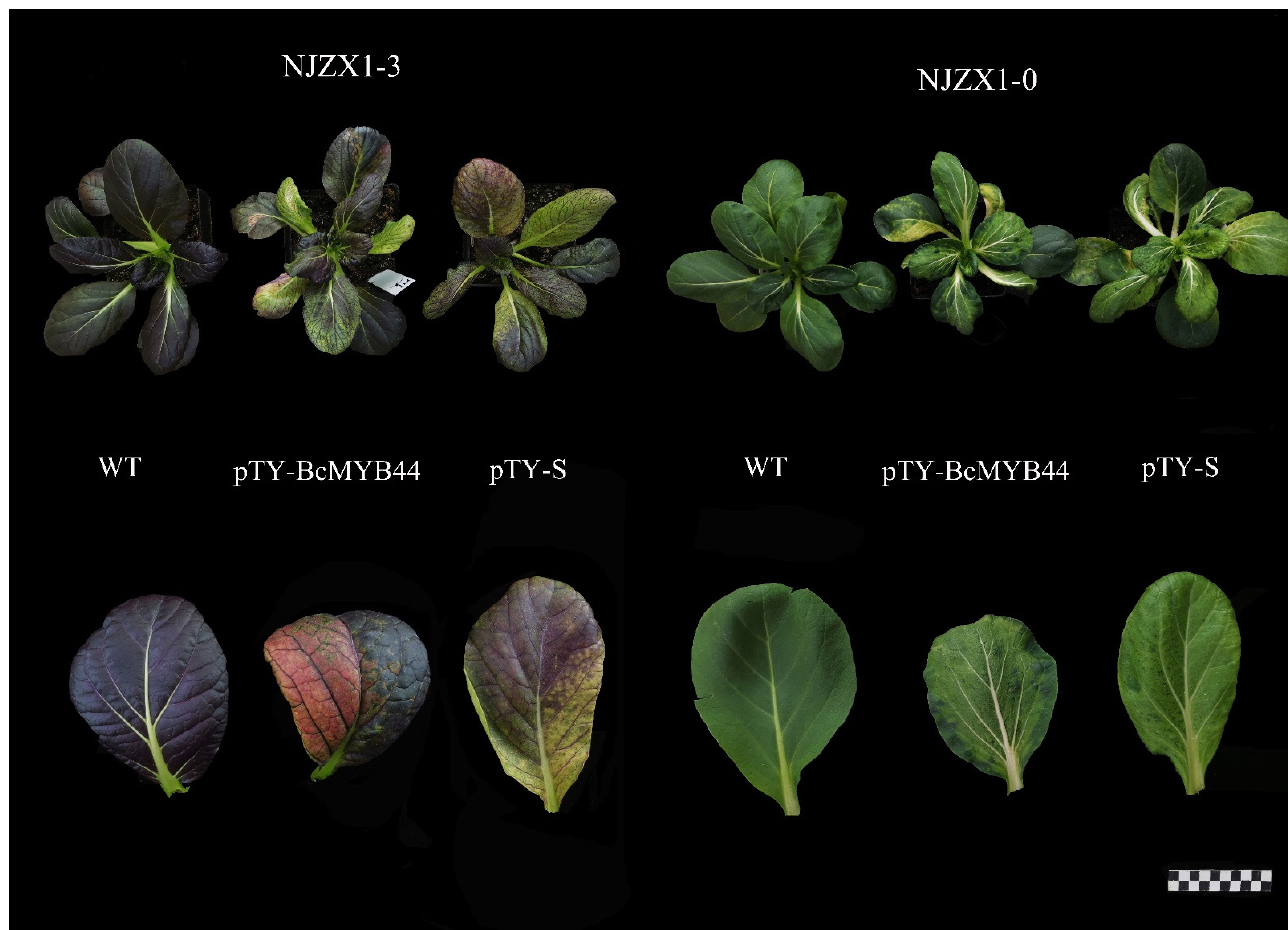
Figure 7. Phenotypic changes of non-heading Chinese cabbage materials after VIGS treatment. From left to right were WT, pTY-BcMYB44, pTY-S of ‘NJZX1-3’; WT, pTY-BcMYB44, pTY-S of ‘NJZX1-0’.(WT: wild type; pTY-BcMYB44: gene scilencing plant; pTY-S: empty vector plant.)